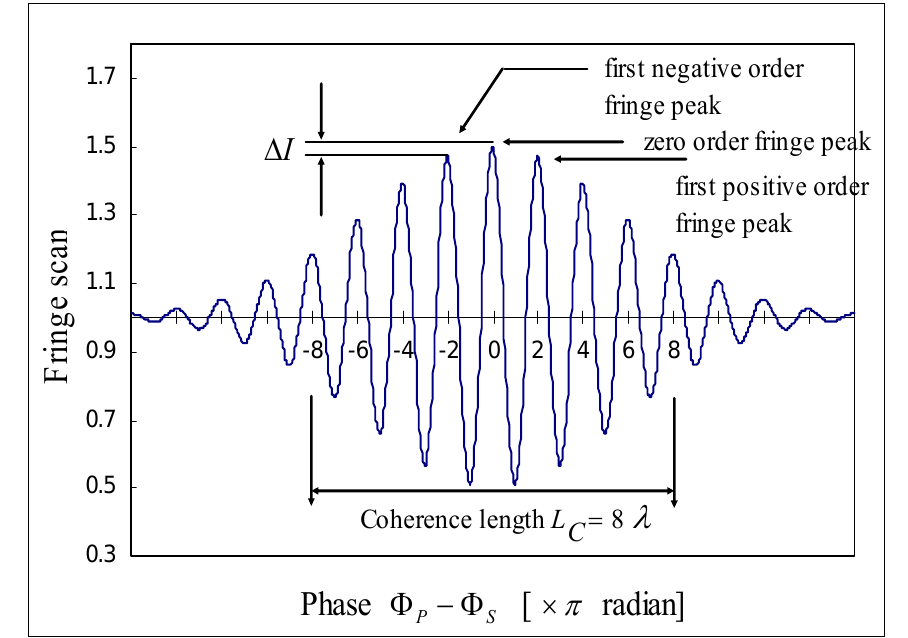
in Equation 1 or I S